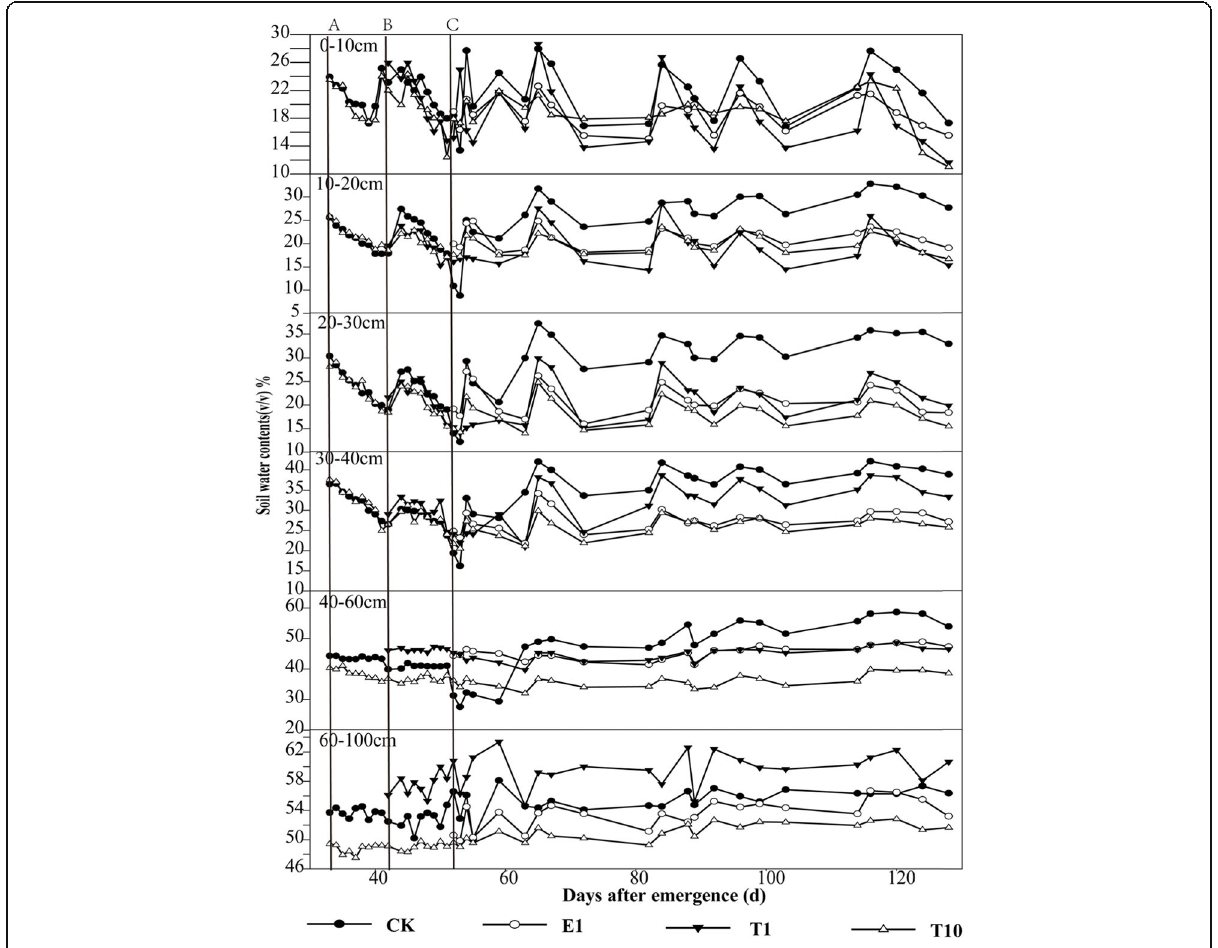
Fig. 3 Soil volume moisture content variation of different soil layer at 33 – 128 days after emergence in 2017 in various treatment groups: 1 and 10 days before the first irrigation (T1, T10, respectively) and 1 day before the second irrigation (E1) after seedling emergence, with one control group of film mulching present across cotton plant growth stages (CK). A, B, and C represent removal of mulch on May 31, June 10, and June 20, 2017, i.e., 10 days, 1 day before the first irrigation, and one day before the second irrigation,